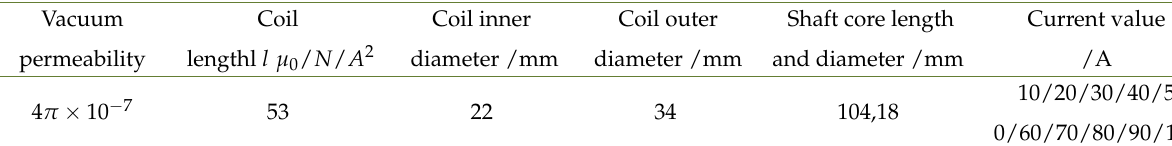
Table 1. Parameters of coil and shaft core.